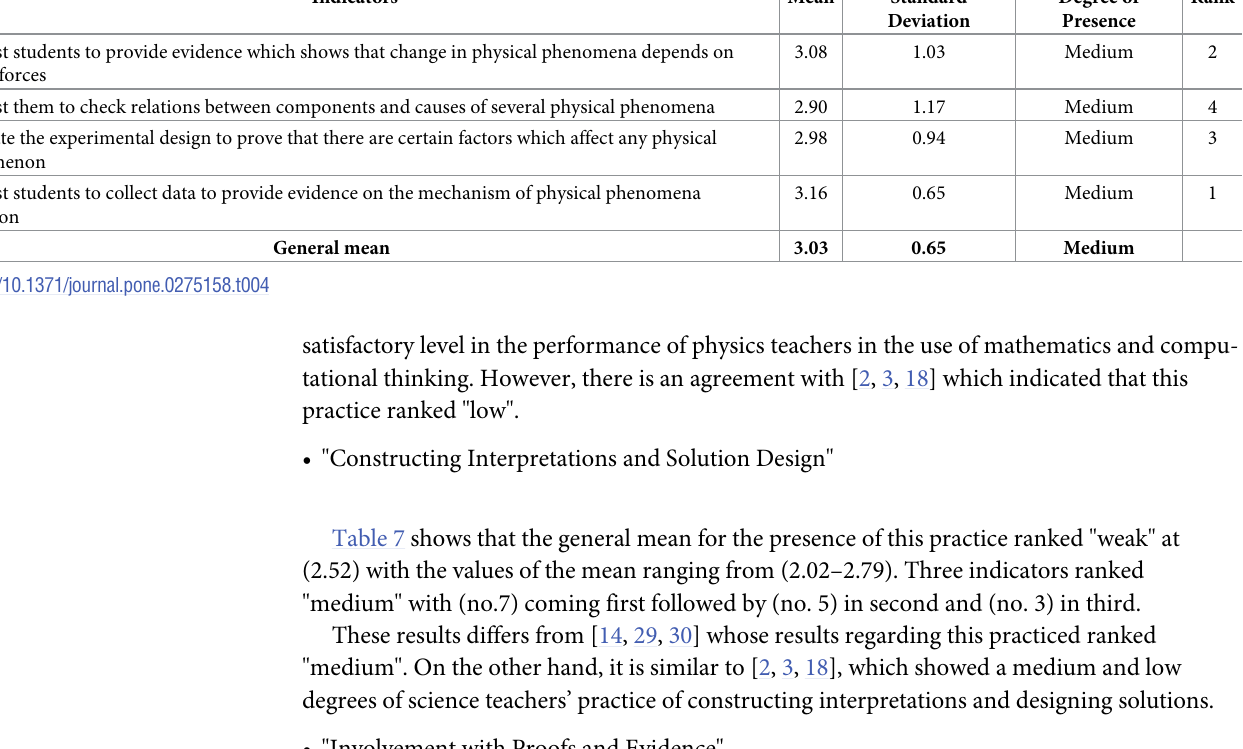
Table 4. The means and standard deviations of the presence of the “planning and carrying out investigations” practice. No.